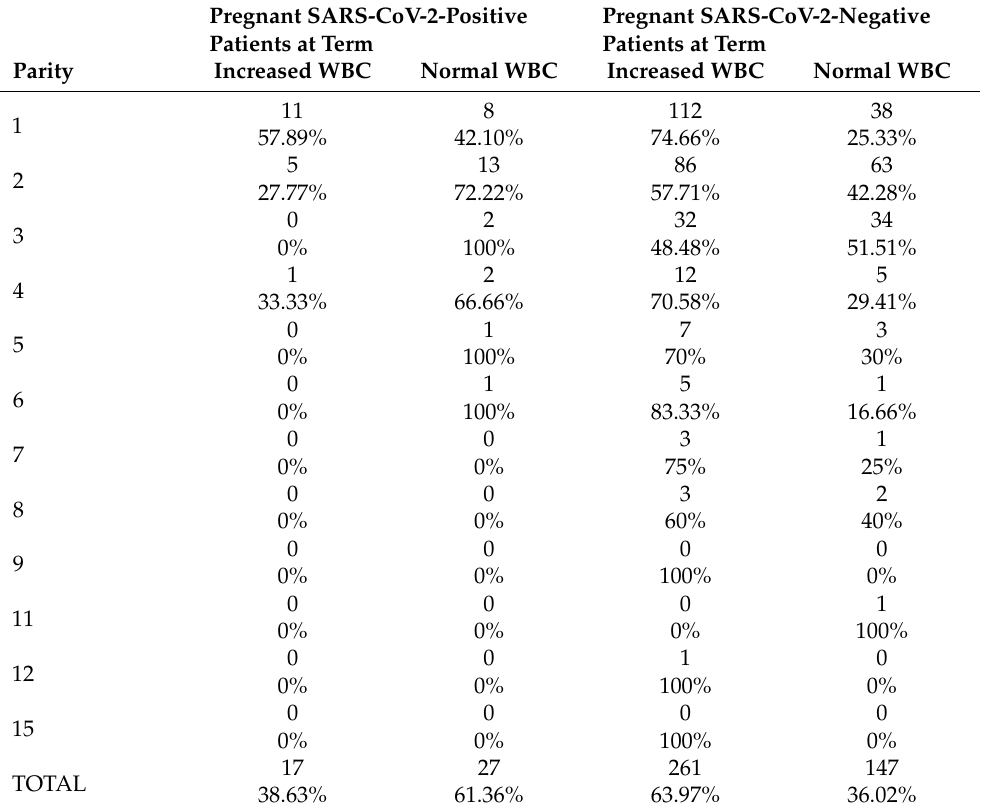
Table 5. Number and percentage of pregnant SARS-CoV-2-positive and negative patients with a WBC over normal limits at term regarding